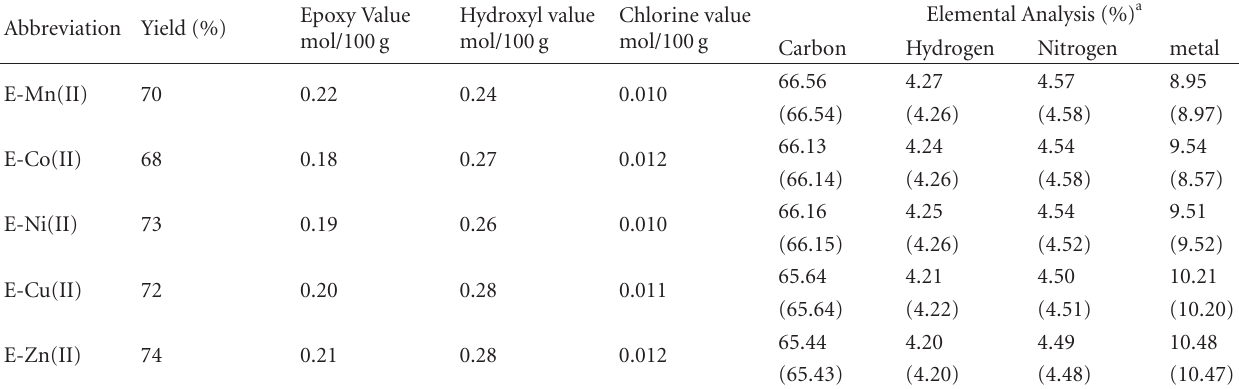
Table 1: Physicochemical properties and elemental analysis of metal-cheated epoxy